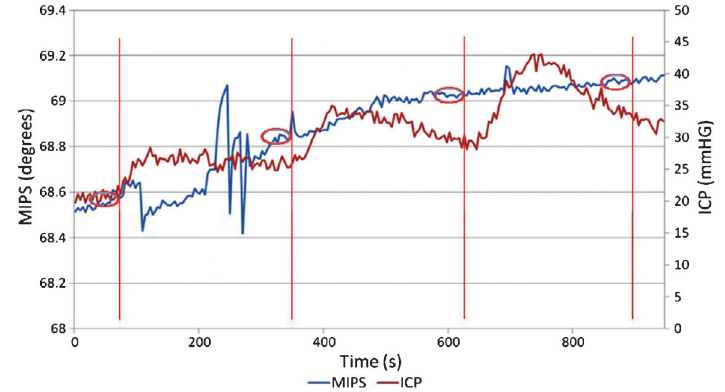
Figure 5. Data from one rabbit with acute cerebral hemorrhage obtained with the magnetic induction phase shift (MIPS) experimental setup and the physiological signal collection device. The MIPS increased from 68.5 6 to 69.1 6 (blue tracing) whereas the intracranial pressure (ICP) increased from 18 to 33 mmHg (red tracing). The red vertical bars indicate injection points, and red circles indicate data